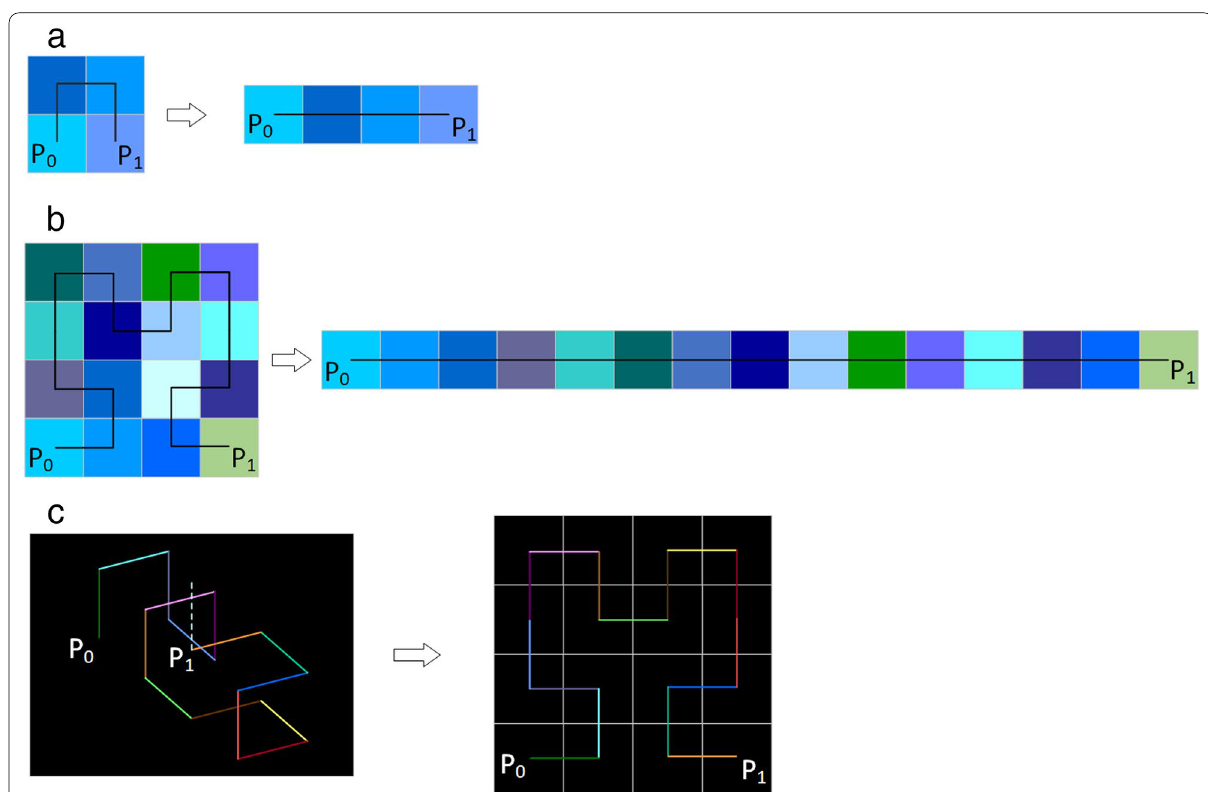
Fig. 3 Two-dimensional Hilbert curves with level 1 ( a ) and level 2 ( b ) were, respectively, stretched into a straight line from P 0 to P 1 . c Example of the dimensionality reduction of a three-dimensional mass with 16 voxels to a two-dimensional matrix with 4 Hilbert curve